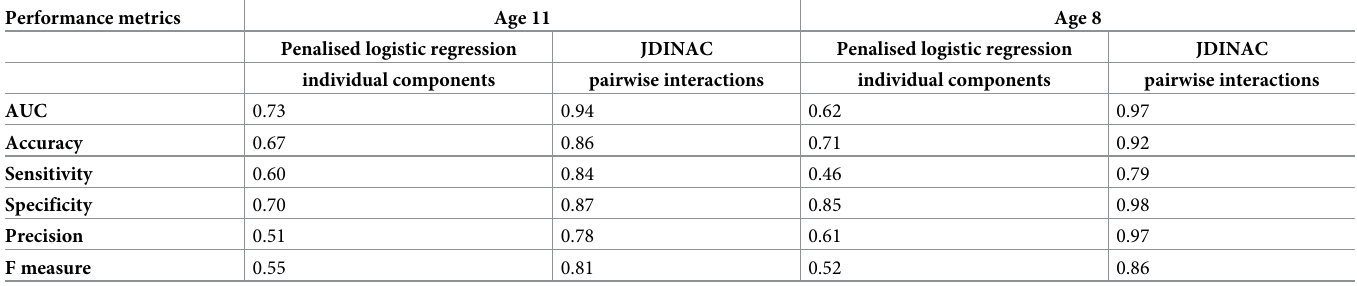
Table 2. Evaluation and comparison of prediction performances of logistic regression based on individual components and JDINAC based on pairwise interactions of sIgE allergens. Performance